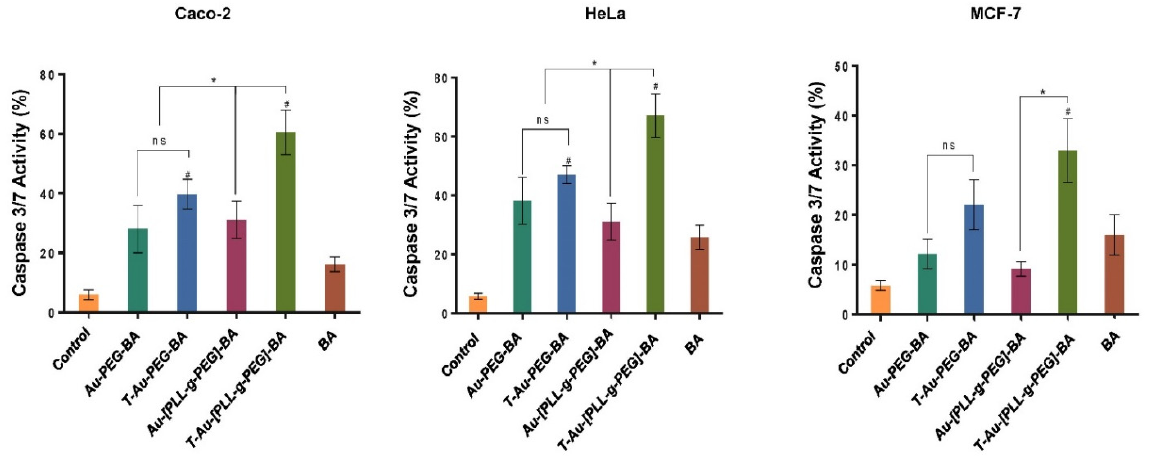
Figure 11. Graphical representation of the effect of targeted and untargeted nanocomplexes on caspases 3 and 7 in Caco-2, HeLa and MCF-7 cells. Data is represented as mean ± SD ( n = 3). * vs. targeted or untargeted nanocomplex, # vs. free drug at p < 0.05. ns = no significant difference.